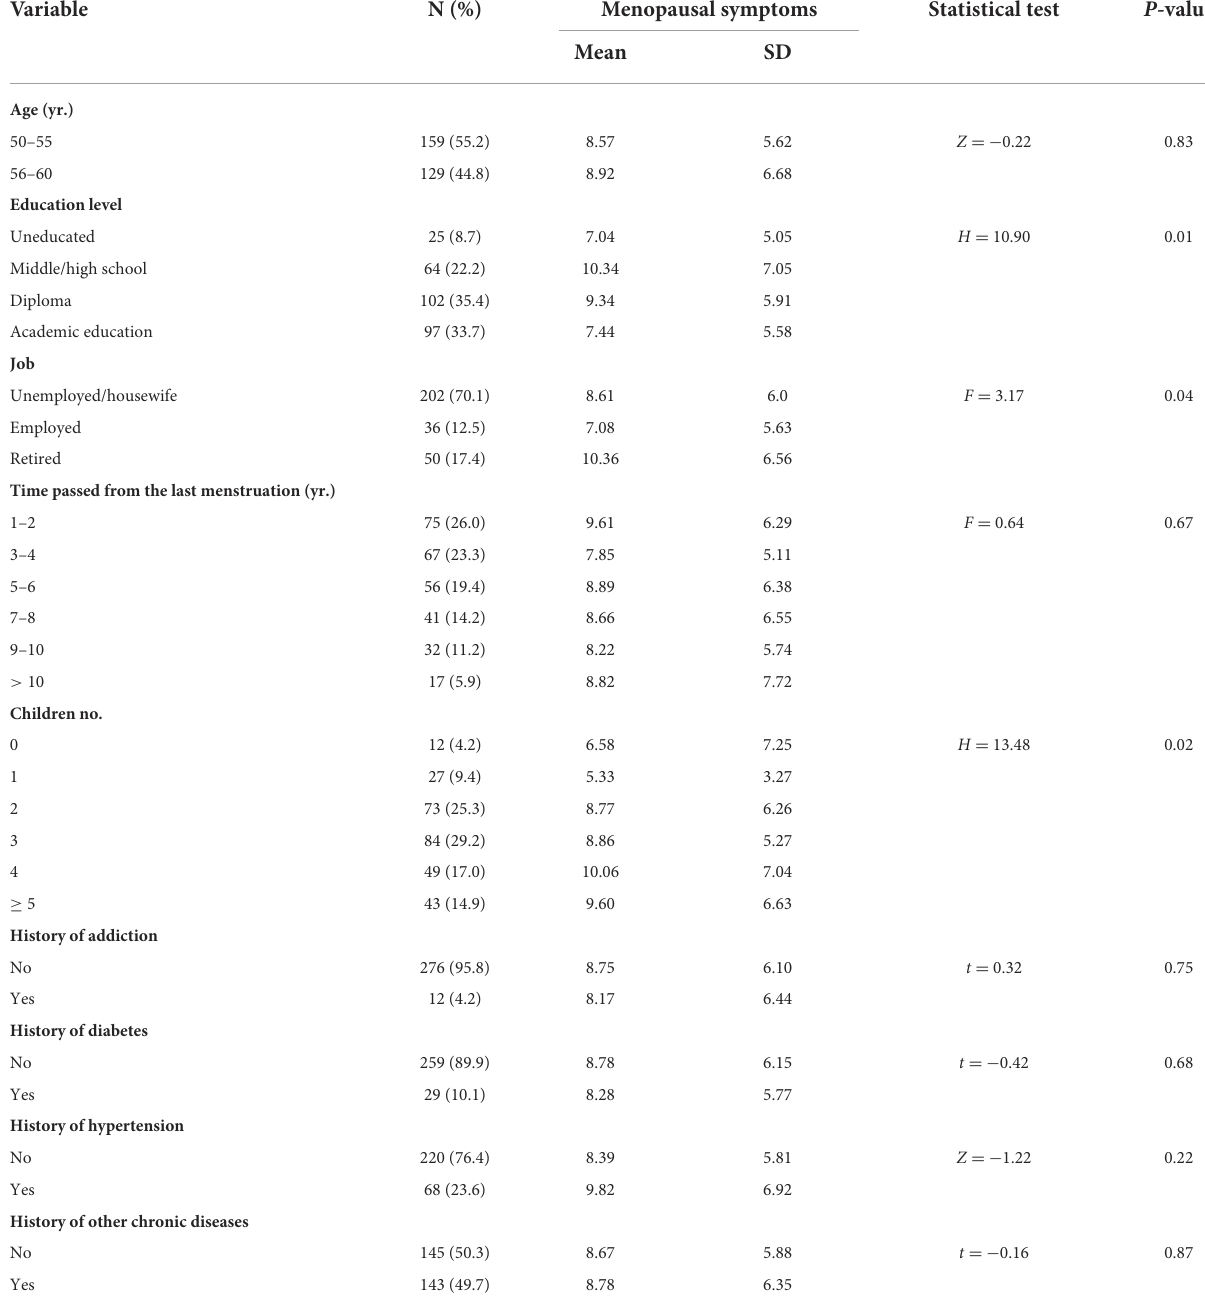
TABLE 1 Demographic and clinical information of the participants and their association with menopausal symptoms. Variable N (%) Menopausal symptoms Statistical test P -value Mean